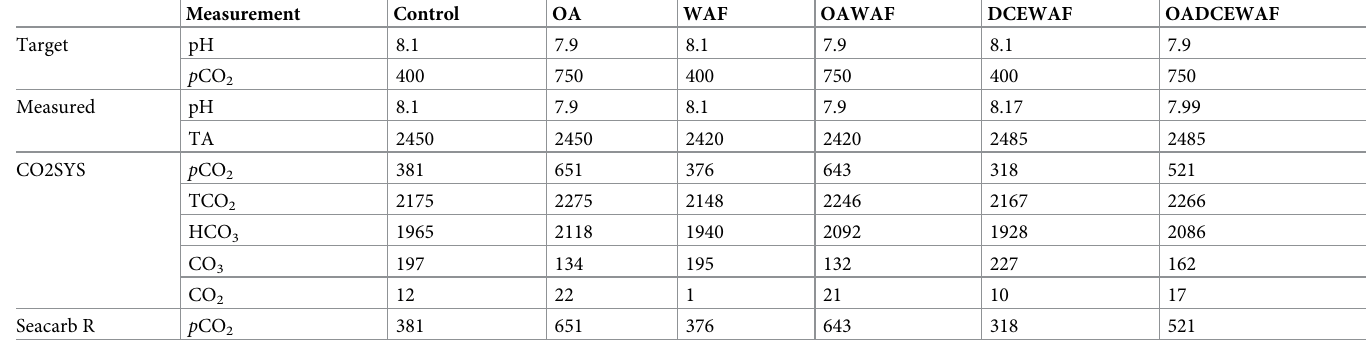
Table 1. Initial (start of the roller table experiments) carbonate chemistry. Outputs from both CO2SYS and Seacarb R for pCO 2 (ppm), TCO 2 ( μ mol kg SW -1 ), HCO 3- ( μ mol kg SW -1 ), CO 32- ( μ mol kg SW -1 ), and CO2 ( μ mol kg SW -1 ) are provided.